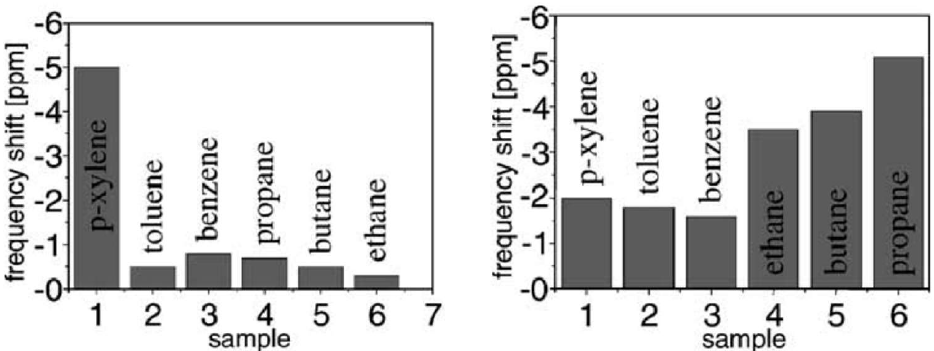
Figure 3. p -Xylene imprinted SAW sensor response to VOCs ( left ) and response from a non-imprinted equivalent ( right ). Both polymers were prepared from polyurethane to give a layer of approximately 40 nm, but only the imprinted polymer used p -xylene as solvent. Reproduced with permission [137]. In the latter example of Alizadeh and Rezaloo, the dynamic range of this sensor was 3.8–46.4 ppm and the limit of detection was 0.8 ppm. It also involved an